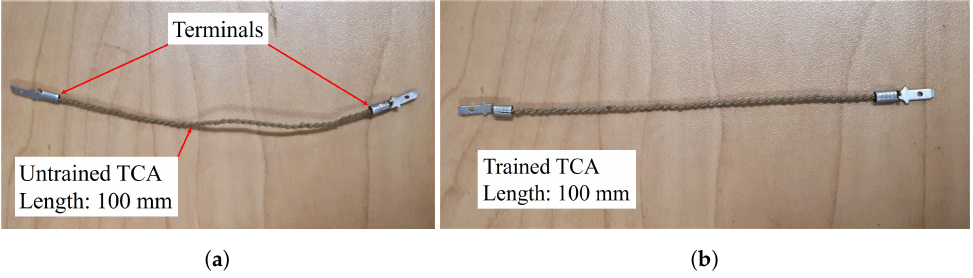
Figure 1. ( a ) Untrained twisted coiled actuator (TCA). ( b ) Trained